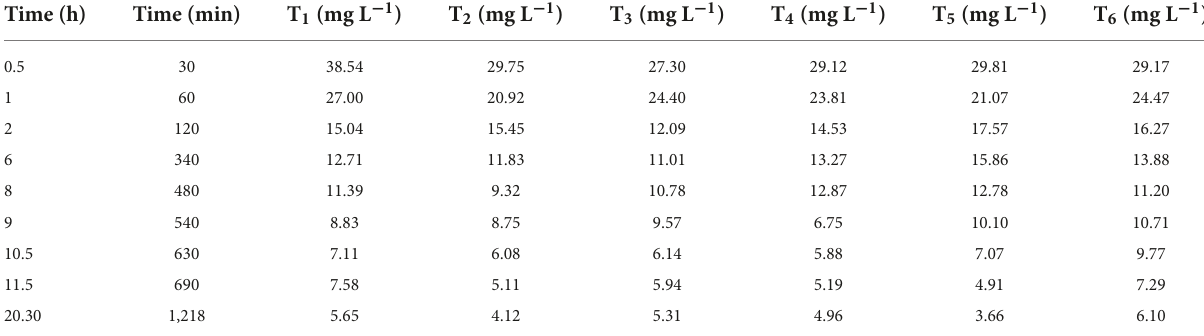
TABLE 2 Concentrations of total Cr for the treatments (T1 = 1% bentonite, T2 = 2% bentonite, T3 = 3% bentonite, T4 = 4% bentonite, T5 = 5% bentonite, T6 = 6% bentonite) in batch adsorption experiment. Time